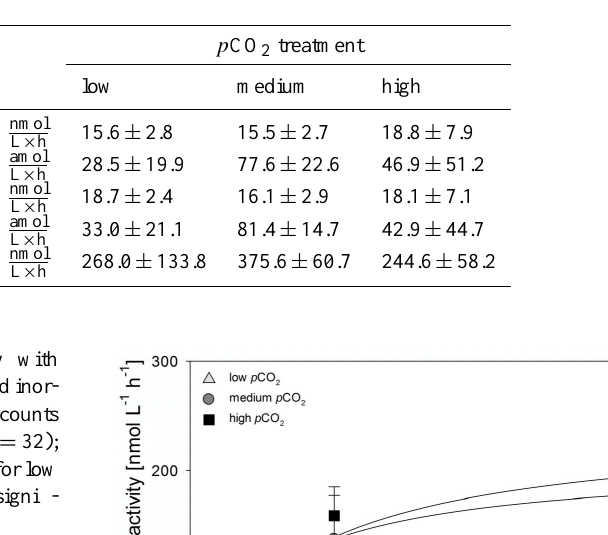
Table 3. Glucosidases and leucine aminopeptidase activities at different p CO 2 ( V max and standard deviation; n = 3) on day 15 (=day of highest activities).